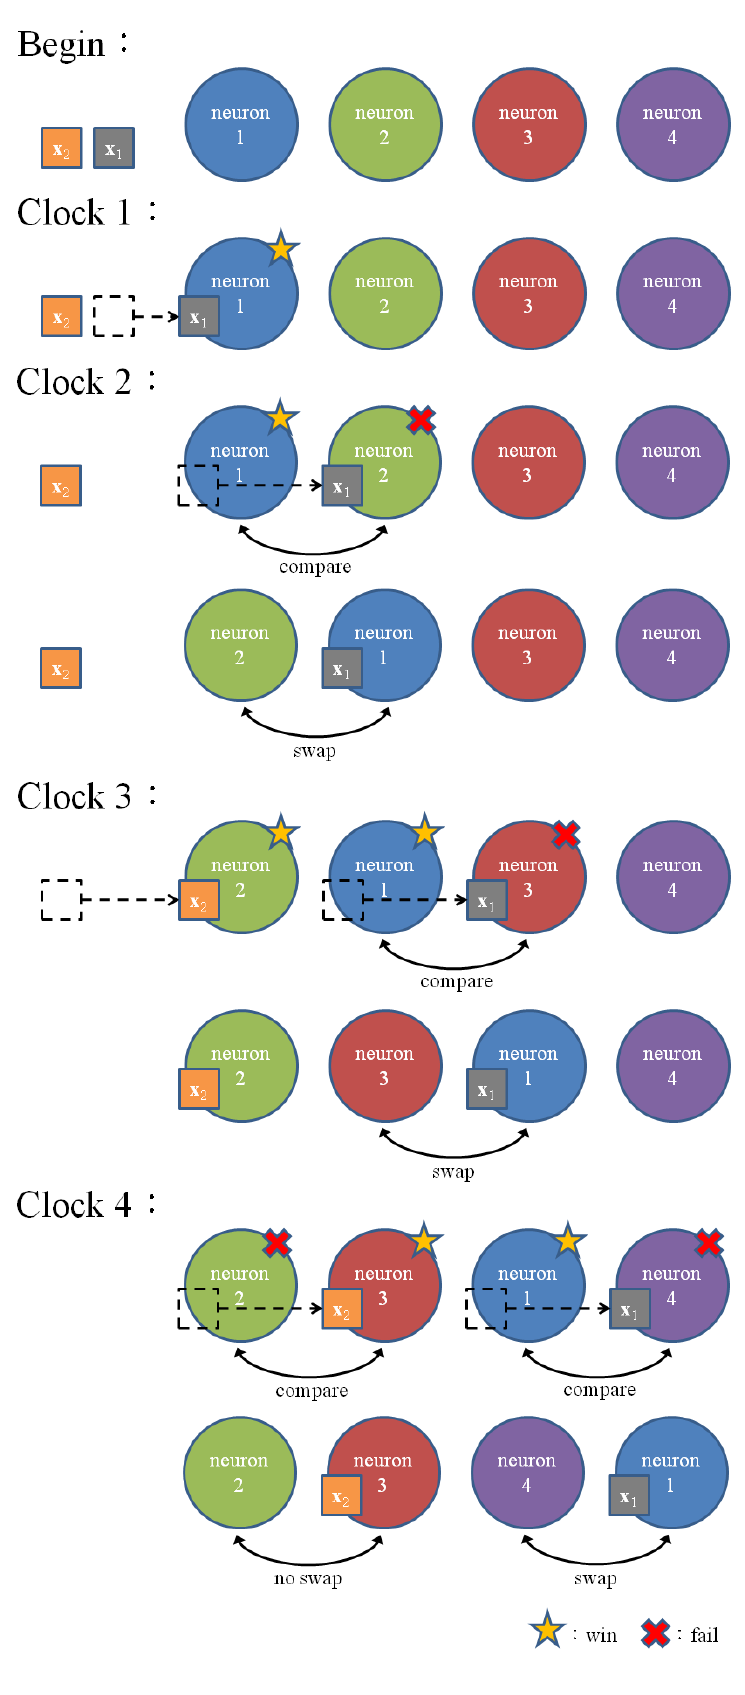
Figure 2. An example of codeword swapping scheme for N = 4 and k = 1